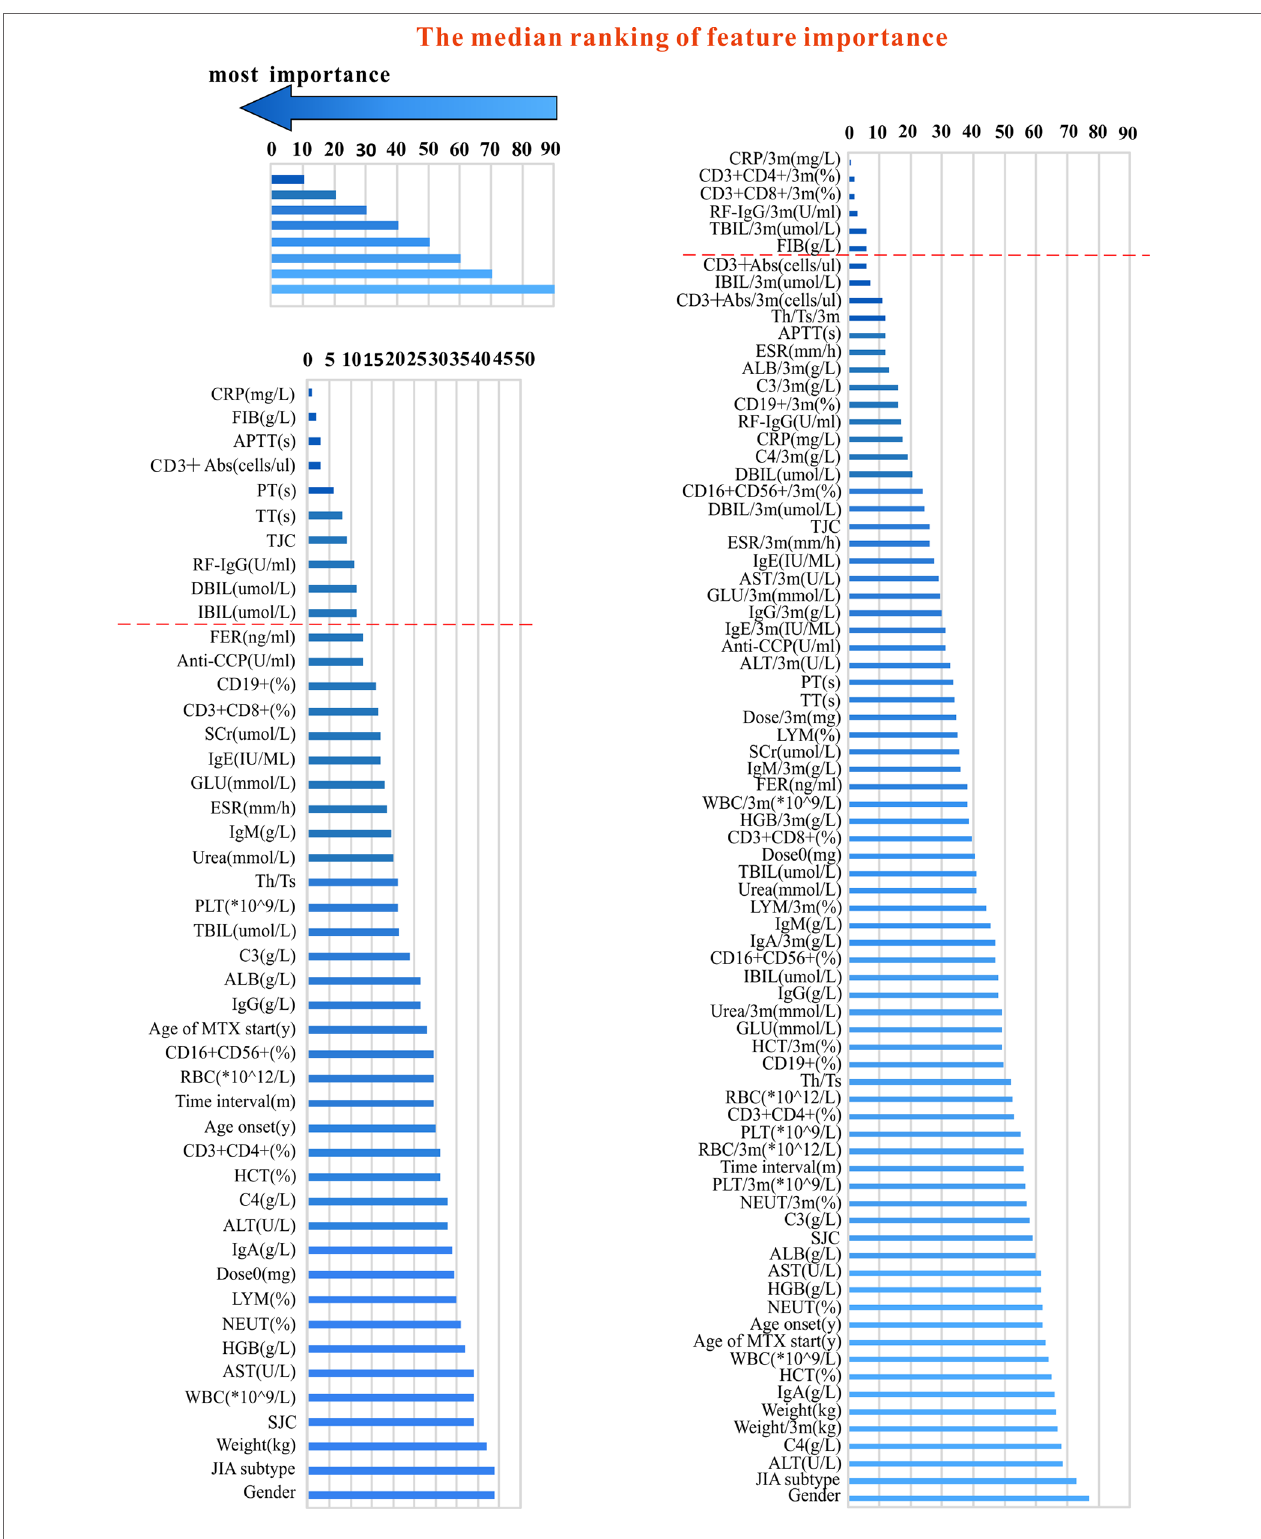
FIGURE 1 | The variables used for modeling and their importance ranking (in order of median importance). The left part of the figure shows the variables used in the pre-administration variables model. The right part of the figure shows a mixture of variables before and after administration (variables collected within 3 months after administration with MTX). The shorter the transverse column (i.e. the smaller the value), the greater importance of the median ranking of the variable (see the top and left